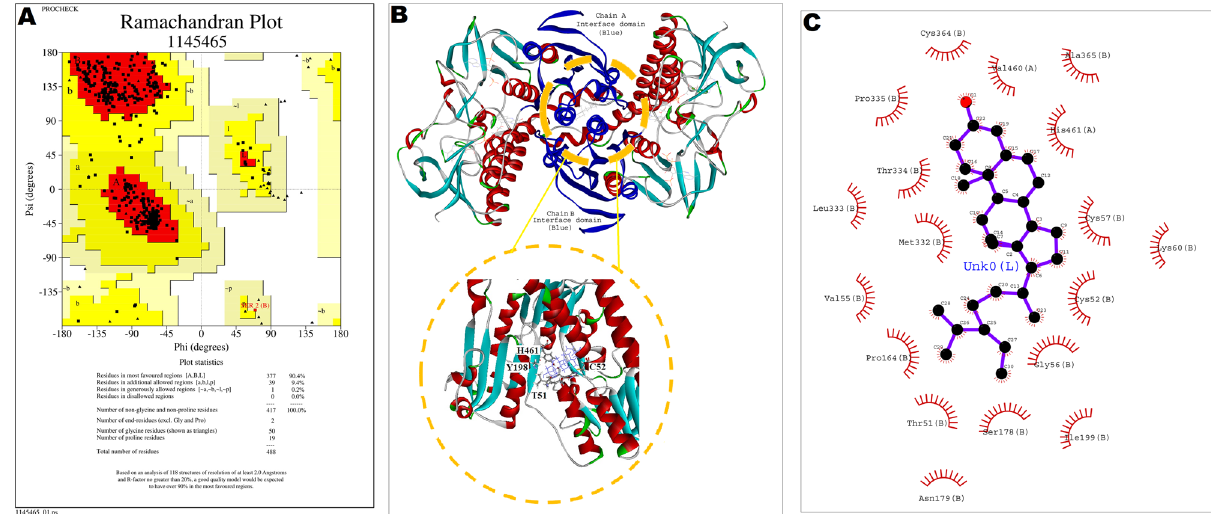
Figure 9. ( A ) Validation of the modelled structure using a Ramachandran plot by PROCHECK analysis. Ramachandran plot showing that 90.4% of amino acid residues are distributed in the allowed region with no amino acids in the disallowed region, indicating good stereochemical fitness of the generated model. ( B ) 3D conformation of the Ld TryR-β-sitosterol CCL docked complex, where the circle indicates a close-up view of the binding interactions. ( C ) Ligplot (2D representation) of the docked conformation of Ld TryR-β-sitosterol CCL represents adjoining interaction residues of Ld TryR denoted by an eyelash